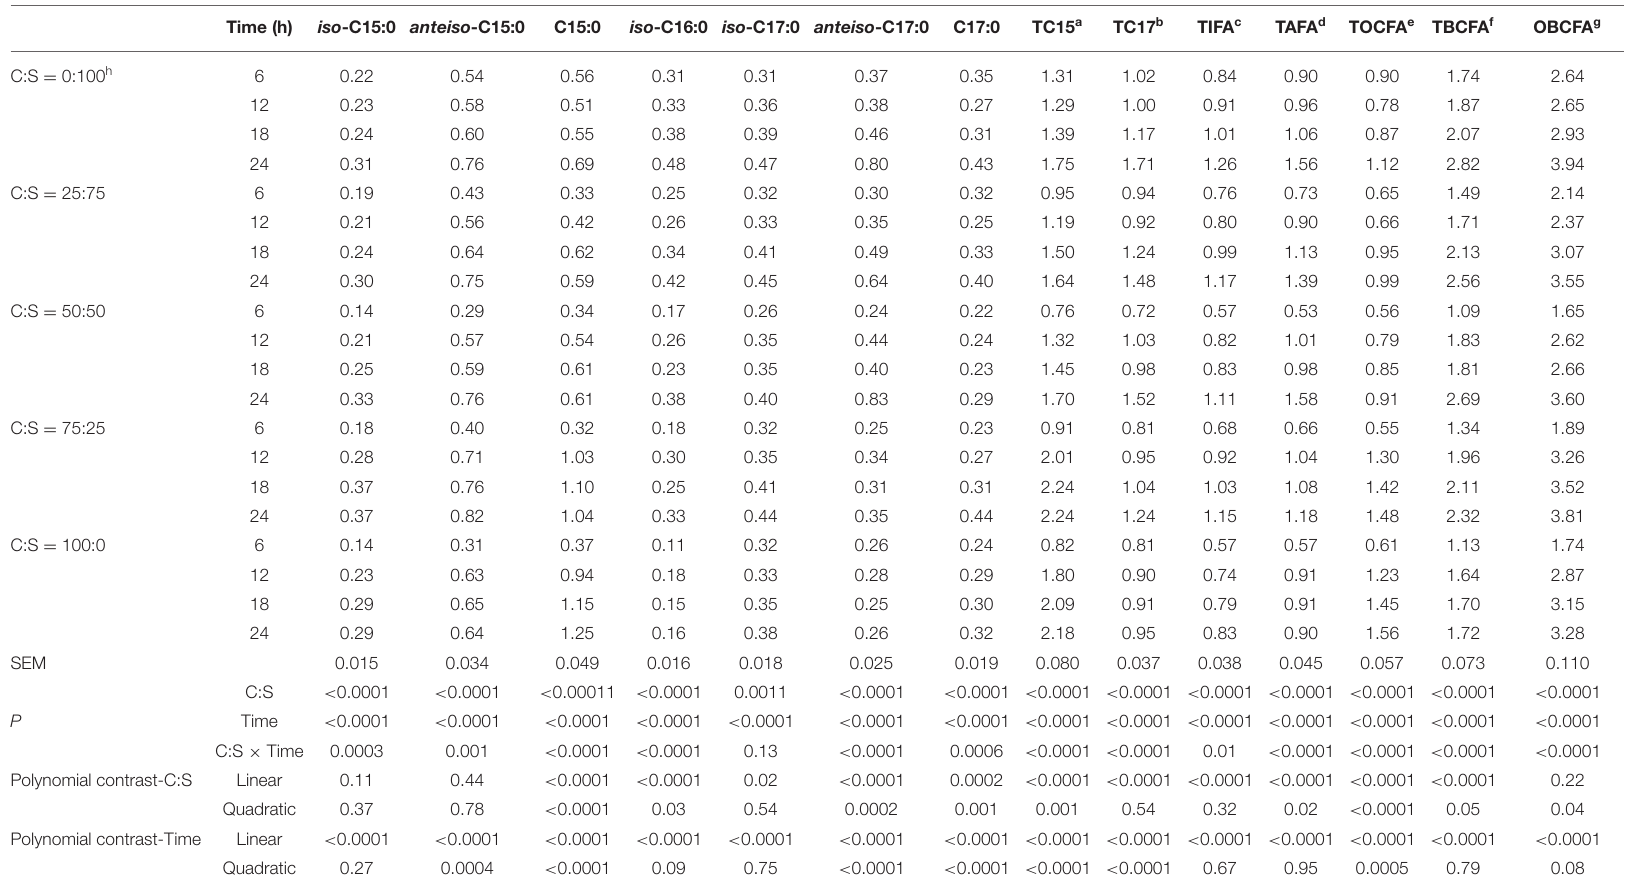
TABLE 3 | Effect of different ratios of cellulose and starch (C:S) on ruminal OBCFA synthesis (mg/g DM) during 24h of incubation in vitro . Time